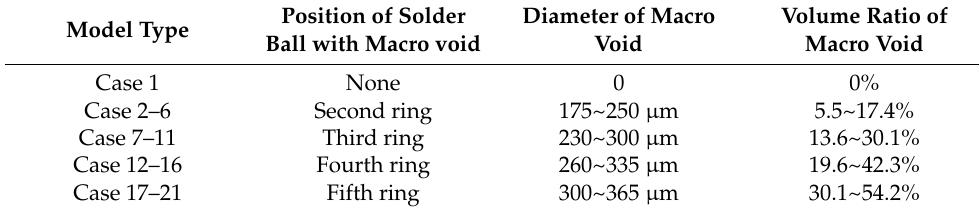
Table 4. BGA models with macro voids at different locations.